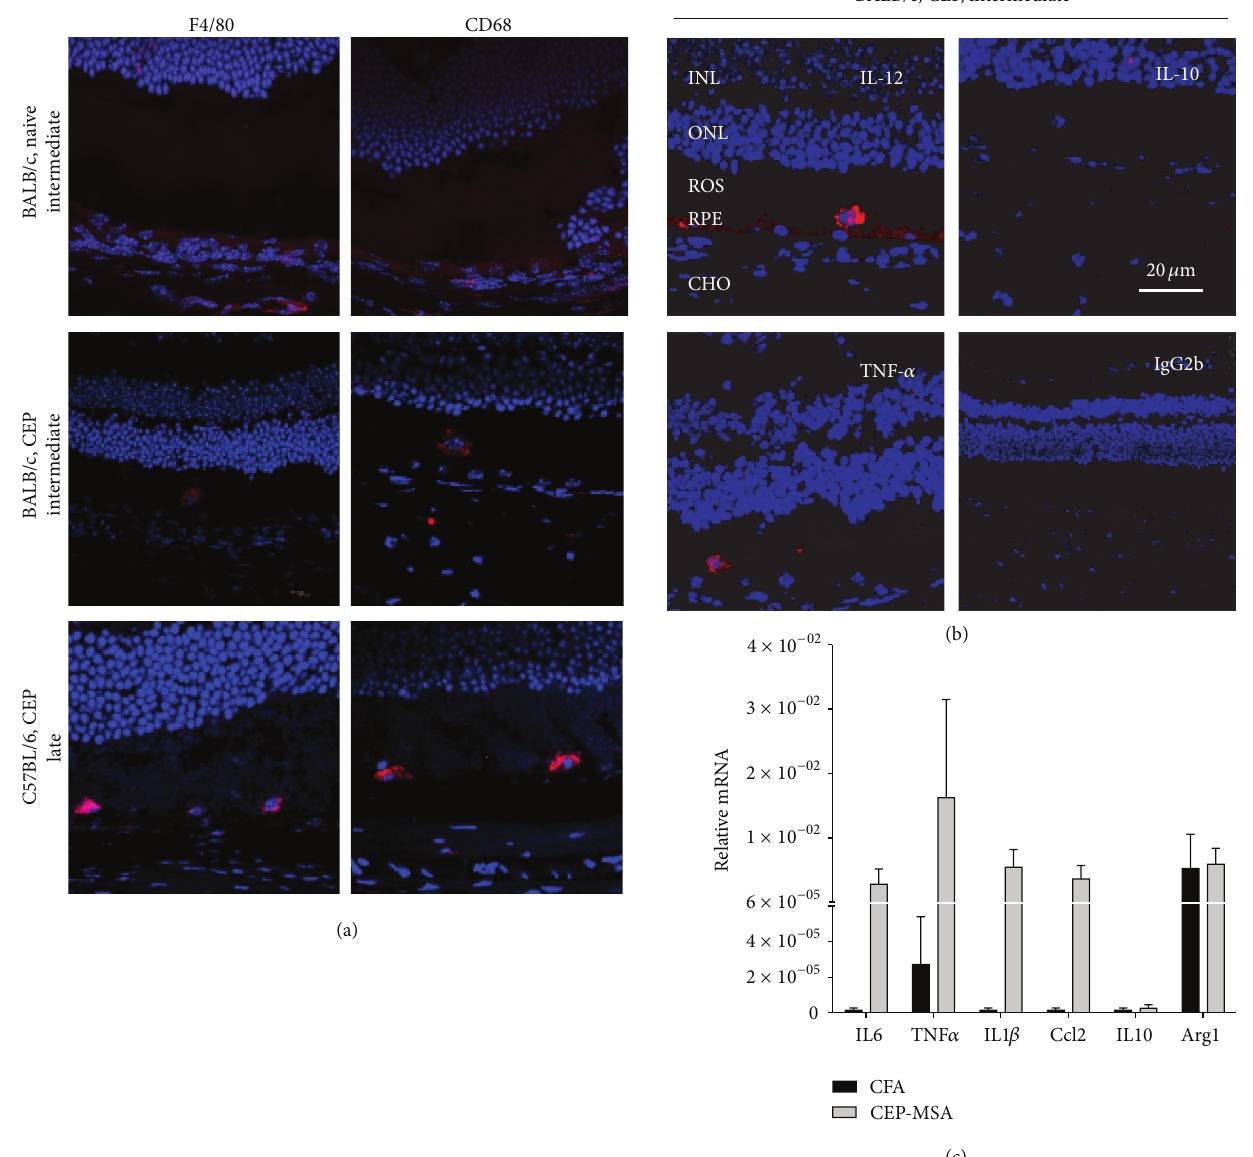
Figure 4: CEP-MSA immunization leads to M1 (TNF- 𝛼 , IL-12 producing) macrophage recruitment and activation in the subretinal space. (a) Frozen sections followed by immunostaining and confocal microscopy. Surface marker stains were used to identify macrophages as the infiltrate cells. F 4/80+ and CD 68+ cells are absent from the RPE of naive mice, but they are found in CEP-MSA-immunized BALB/c and B6 mice. (b) Intracellular stains for TNF- 𝛼 , IL-12, and IL-10 production were used to determine the phenotype of the activated macrophages observed in CEP-MSA BALB/c mice at the intermediate recovery time. IgG2b was used as isotype control. Representative images are shown (from 3–5 mice per group per experiment; two or three independent experiments were performed for each strain). INL: inner nuclear layer; ONL: outer nuclear layer; ROS: rod outer segment; RPE: retinal pigment epithelium; CHO: choroid. The scale marker represents a 20 𝜇 m length. (c) Infiltrating macrophages from B6 mice were isolated by laser microdissection, and RNA was obtained for qPCR analysis of gene expression. Relative mRNA (in arbitrary units) was calculated using the 2 −Δ Ct method with Actin as the calibrator gene. Transcripts for M1 marker genes (IL-1 𝛽 , TNF, and Ccl2) were detectable in 3 out of 5 CEP-MSA-immunized mice but were not present in CFA age-matched controls ( 𝑛 = 4 ). M2 marker expression did not correlate with CEP immunization: IL-10 was completely absent, whereas the levels of Arg-1 did not increase. Results are representative of at least two independent laser capture